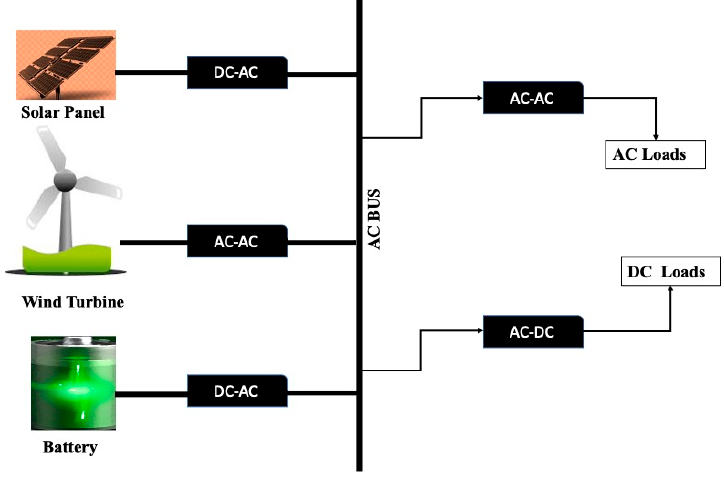
ff -grid AC Figure 4. Typical off-grid AC microgrid. Figure 4. Typical off-grid AC microgrid. Figure 4. Typical o